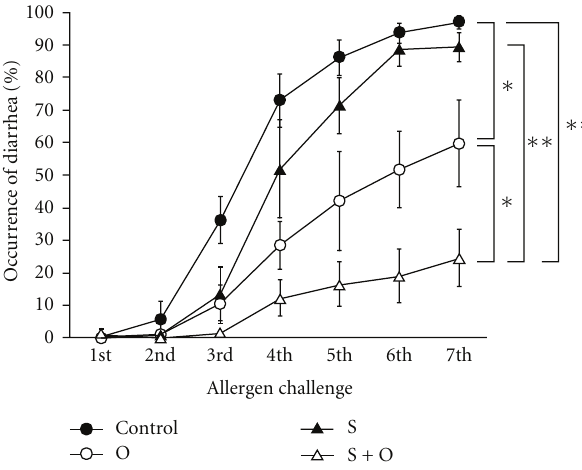
Figure 2: E ff ects of the maternal exposure to food antigens during lactation and the maternal allergic status on allergic symptoms in FA model. O ff spring breastfed by OVA-sensitized and OVA-exposed lactating mothers were more protected from the development of allergic symptoms of FA compared with o ff spring from OVA- nonsensitized and OVA-exposed lactating mothers. Data are shown as the means ± SE (8 independent experiments, total n = 62–181). ∗ P < 0 . 05, ∗∗ P < 0 . 01.